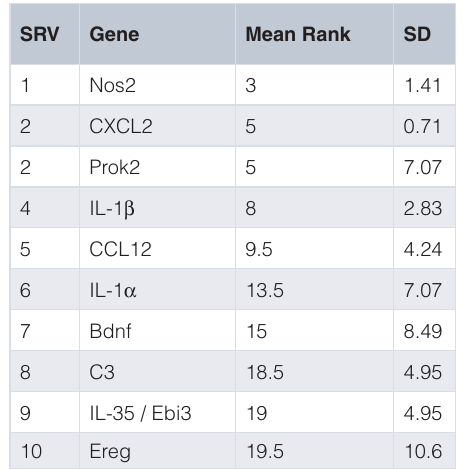
Table 5. Super rank values (SRV), consolidating cytokine up-regulation following acute and repeated bladder inflammation with